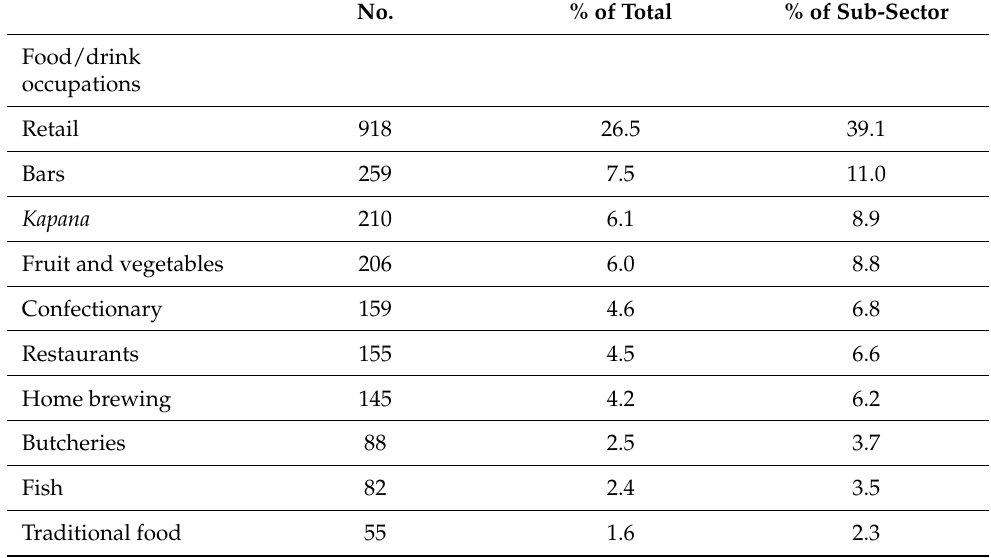
Table 1. Informal sector occupations in urban